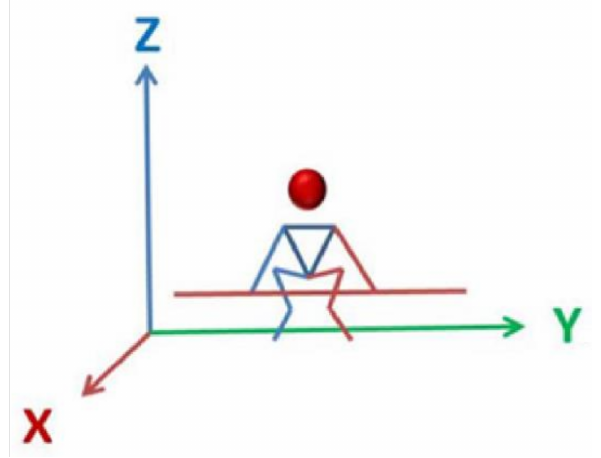
Figure 2. Experimental setup of the three-dimensional motion